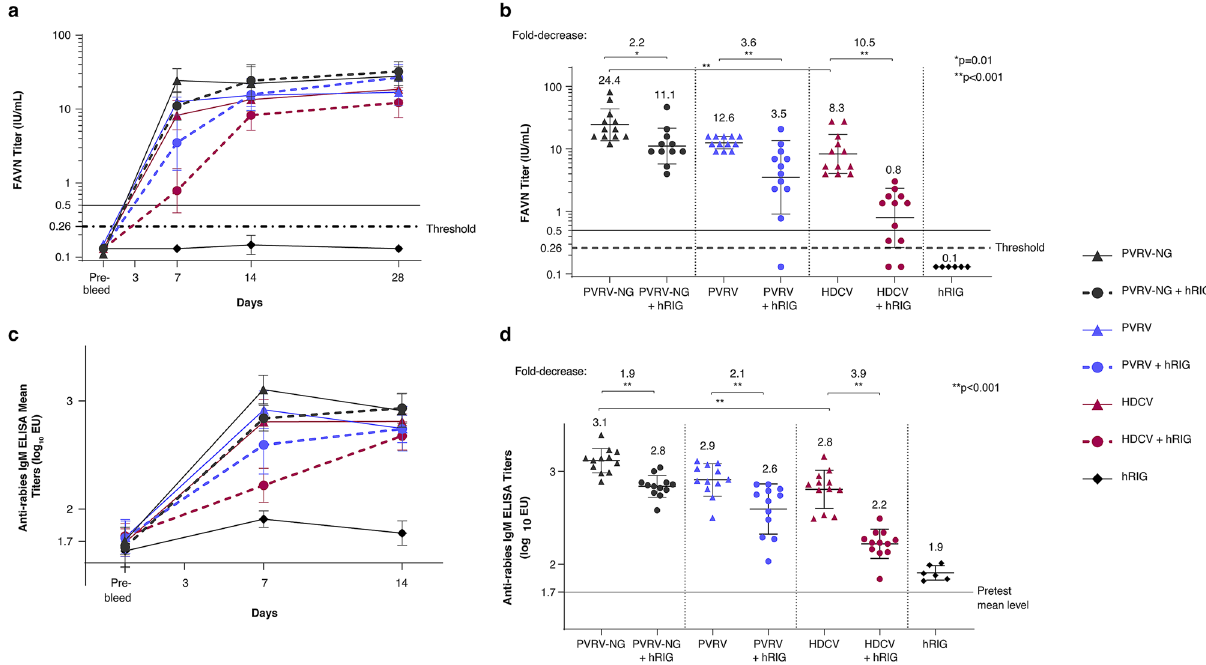
Figure 3. Immunogenicity of PVRV-NG and standard-of-care vaccines in presence of human rabies immunoglobulin (hRIG) administered by intramuscular (IM) injection according to post-exposure prophylaxis regimen. In experiment 1 , adult female hamsters (n = 12 per group) were vaccinated on Days 0, 3, 7 and 14 by IM injection with 1:10 human dose of PVRV-NG, PVRV, or HDCV and co-injected or not on Day 0 with hRIG (20 IU/kg). ( a ) Serum rabies virus neutralizing antibody (RVNA) levels were measured by fluorescent antibody virus neutralization test (FAVN) on blood samples collected on Days -10 (10 days prior to Day 0; pre-bleed), 7, 14, and 28. The lower level of detection in FAVN was of 0.26 IU/mL as shown by the dotted line . The continuous black line indicating 0.5 IU/mL is the WHO specified standard serum RVNA titer considered as an adequate immune response to rabies vaccination in humans. Data are expressed as the mean ± SEM. ( b ) Serum RVNA titers measured 7 days after the first immunization. ( c ) Specific anti-rabies IgM titers were measured by ELISA on blood samples collected similarly as that of FAVN. ( d ) Individual IgM ELISA titers measured 7 days after the first immunization. The mean value obtained with pre-test hamster sera is indicated with a specific continuous PVRV, and HDCV, respectively, versus vaccine alone. At the following time-points, no more difference in the seroneutralizing titers was evidenced between vaccine groups with or without co-injection of hRIG (Fig. 3b). The group injected with hRIG alone did not show any detectable response at the tested time-points (D7, D14 and 28), as expected from the preliminary study. The specific rabies ELISA IgM responses were in line with those measured by FAVN titration with mean responses following analogous kinetics as that of FAVN (Fig. 3c). At Day 7, the mean ELISA titers were signifi- cantly higher by twofold for PVRV-NG as compared with HDCV (p < 0.001) alone. The mean ELISA titers meas- ured for the groups injected with vaccine and hRIG were significantly lower than those for the corresponding vaccine alone groups (p < 0.001), with 1.9- (below but very close to the twofold limit), 2.1-, and 3.9-fold decrease for PVRV-NG, PVRV, and HDCV vaccines, respectively (Fig. 3d).